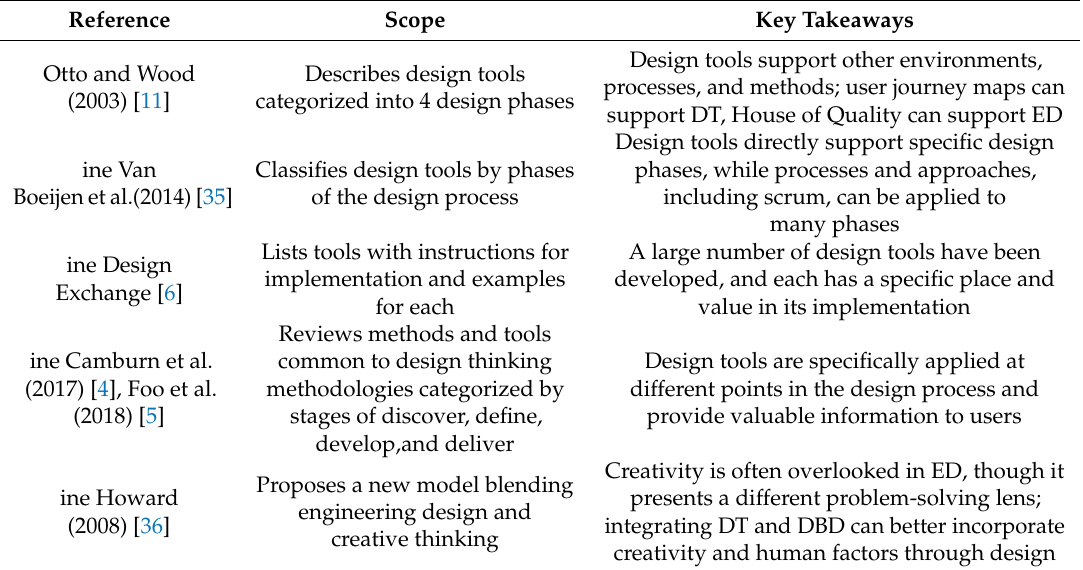
Table 2. Engineering design approach